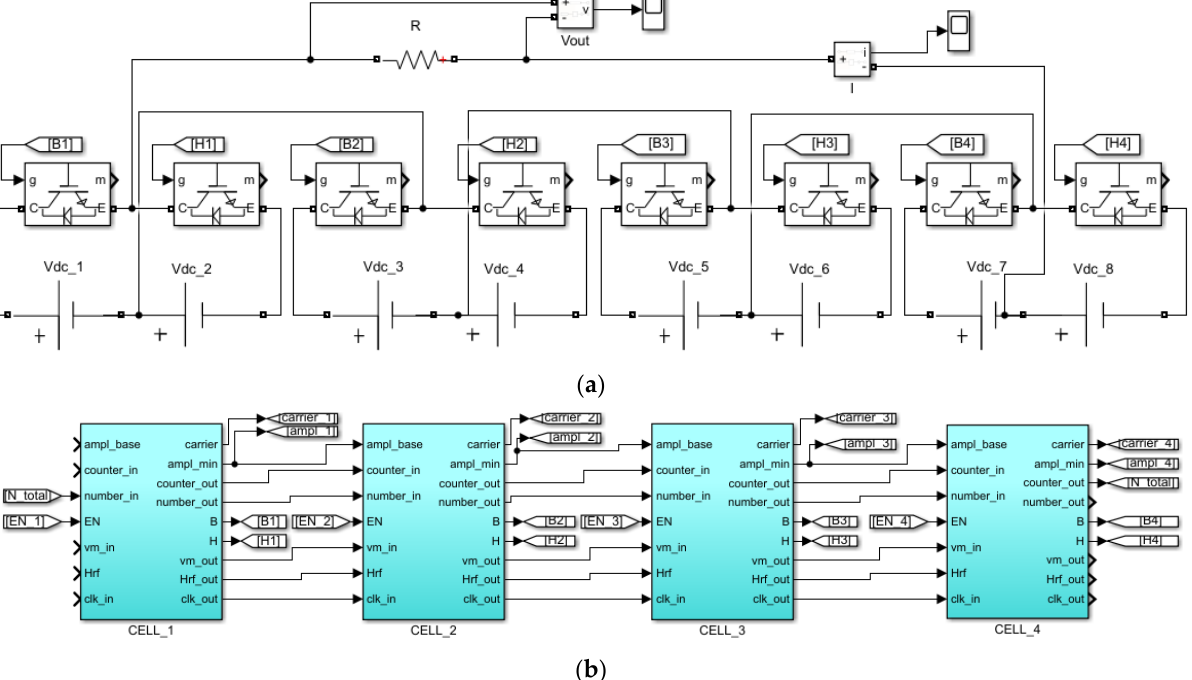
Figure 11. Simulation model of the multilevel DC/AC converter (five levels), ( a ) topology; ( b ) connection between each cell controller. Table 3. Parameters of four-phase DC/DC converter.